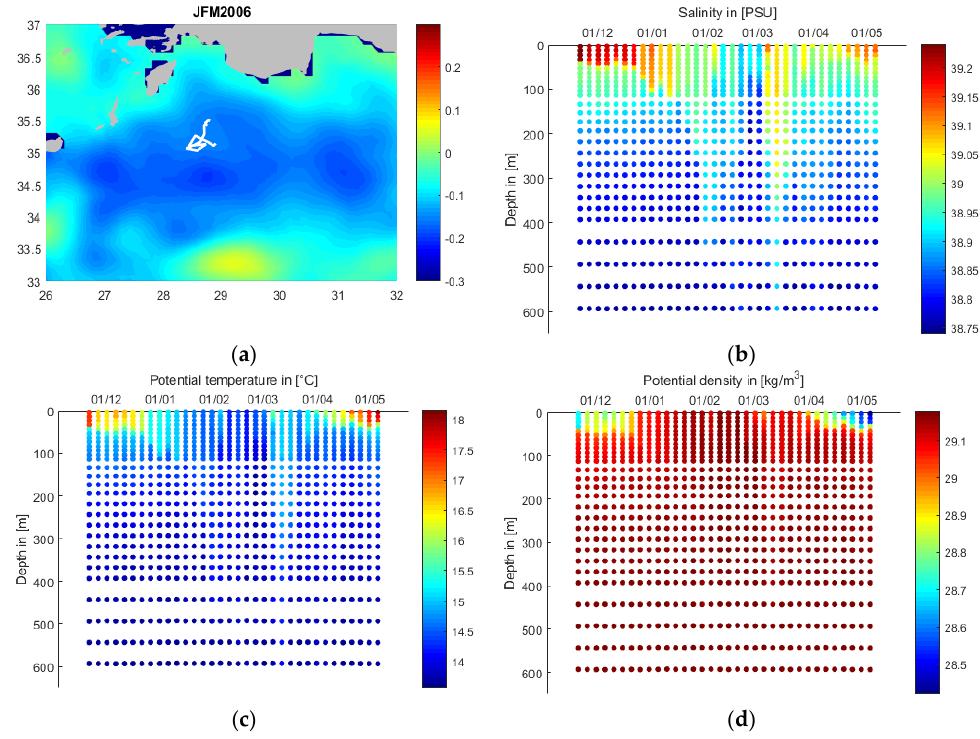
Figure 6. ( a ) Mean sea surface height (SSH, m) and float trajectory of float WMO 6900098 for JFM 2006. ( b ) Salinity (PSU), ( c ) potential temperature (°C) and ( d ) potential density (kg/m 3 ) from ( b ) Salinity (PSU), ( c ) potential temperature ( ◦ C) and ( d ) potential density (kg / m 3 ) from December 2005 to April